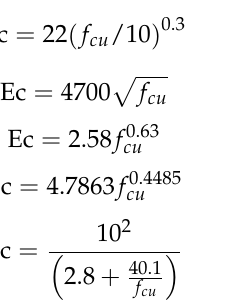
Figure 11. Correlation between compressive strength and tensile strength.